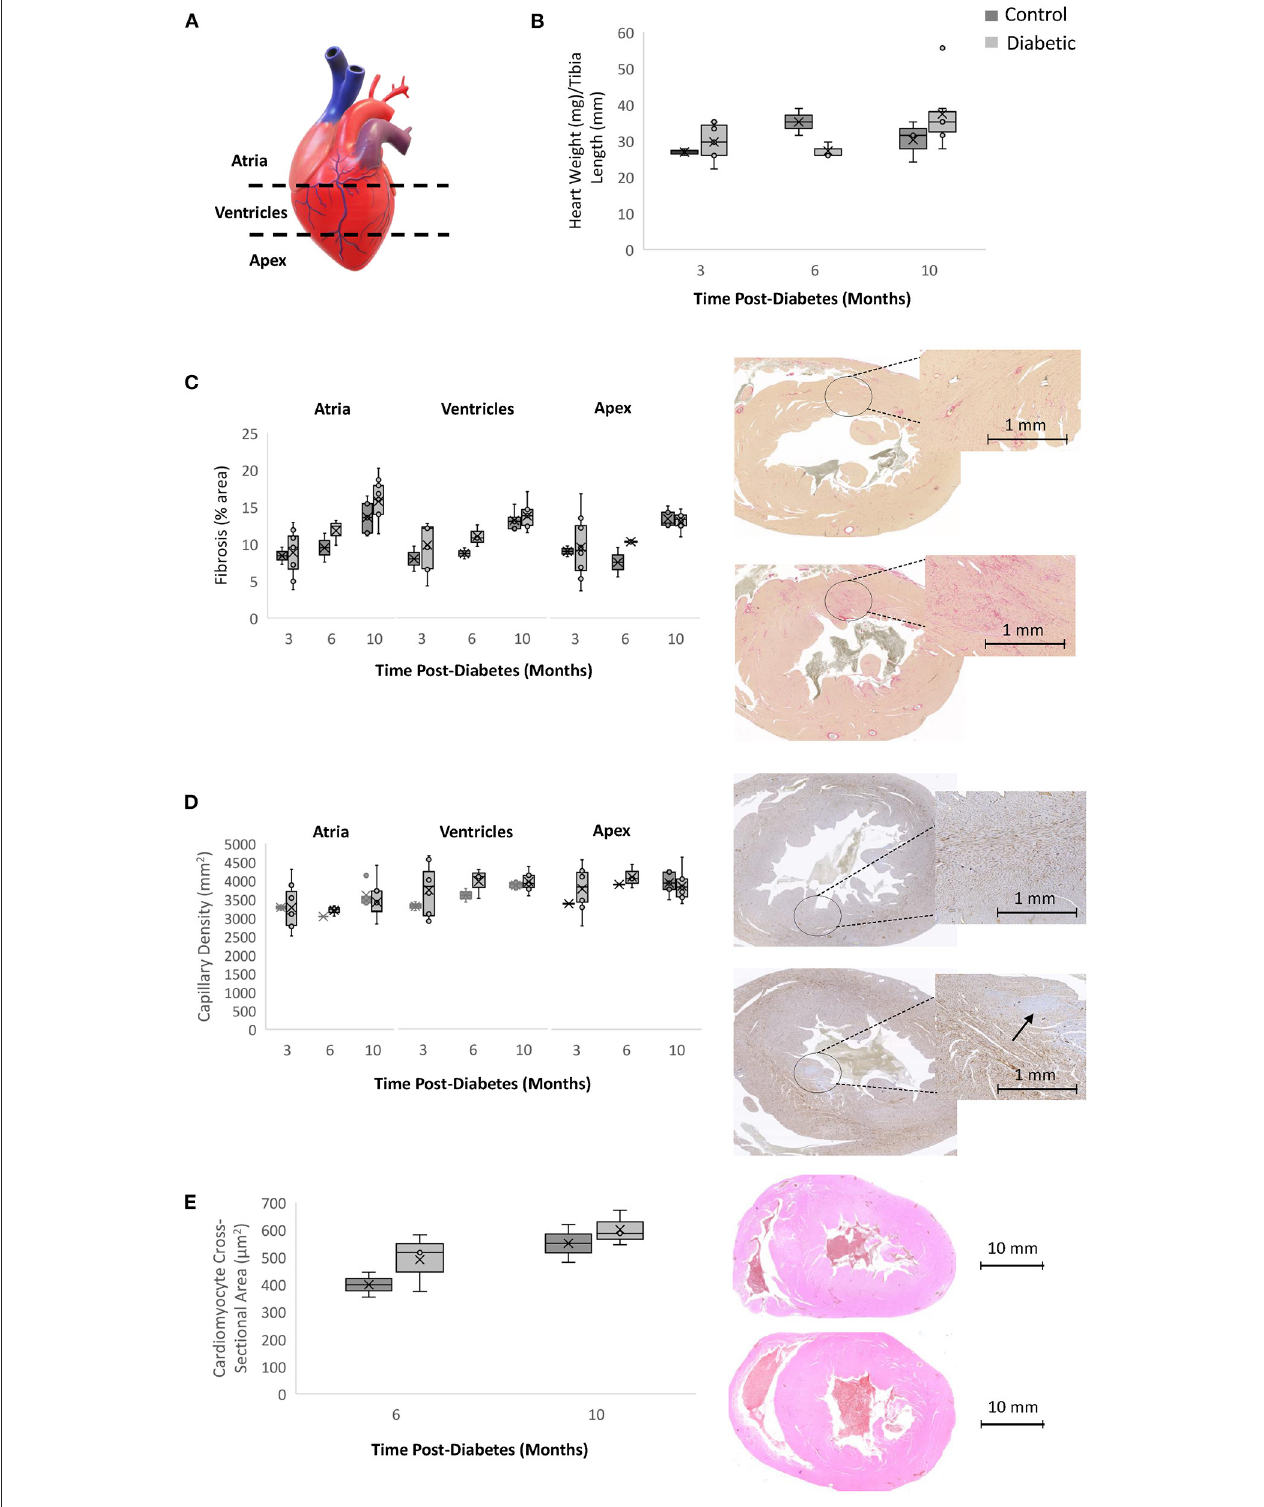
FIGURE 9 | Histology analysis on rodent hearts. Timepoints refer to time post-diabetes at 3 months ( n = 2 control, n = 8 diabetic), 6 months ( n = 2 control, n = 3 diabetic), and 10 months ( n = 5 control, n = 9 diabetic). (A) Schematic representing the three sections of the heart where histology was performed (atria, ventricles, and apex). (B) Heart weight measured immediately post-sacrifice and heart weight-to-tibial length ratio. (C) Interstitial fibrosis quantified as percentage of collagen